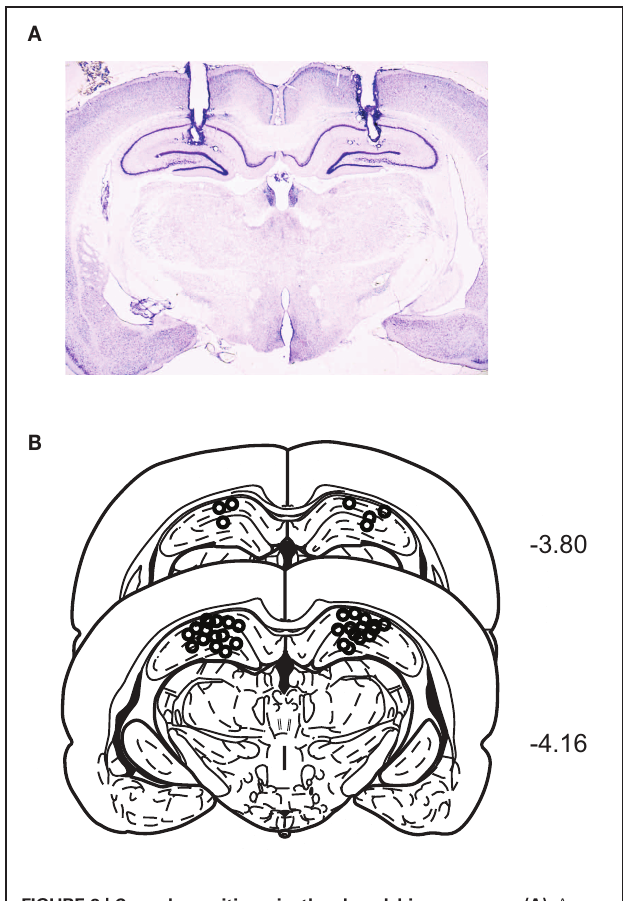
FIGURE 2 | Cannula positions in the dorsal hippocampus. (A) A representative Nissl-stained section showing bilateral cannula tracks targeting the dorsal hippocampi. (B) Schematic illustration of the cannula-tip positions of all animals used in the current study.